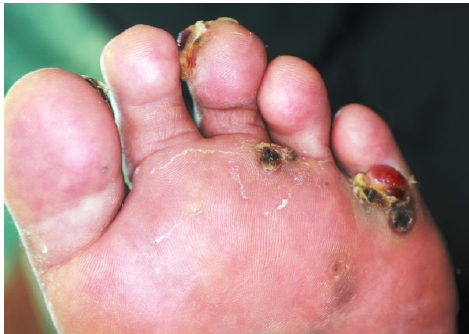
Figure 2. Physically, tumor nodules had expanded and ulcerated on both soles of his feet and his right thigh. (Image of the left sole.)